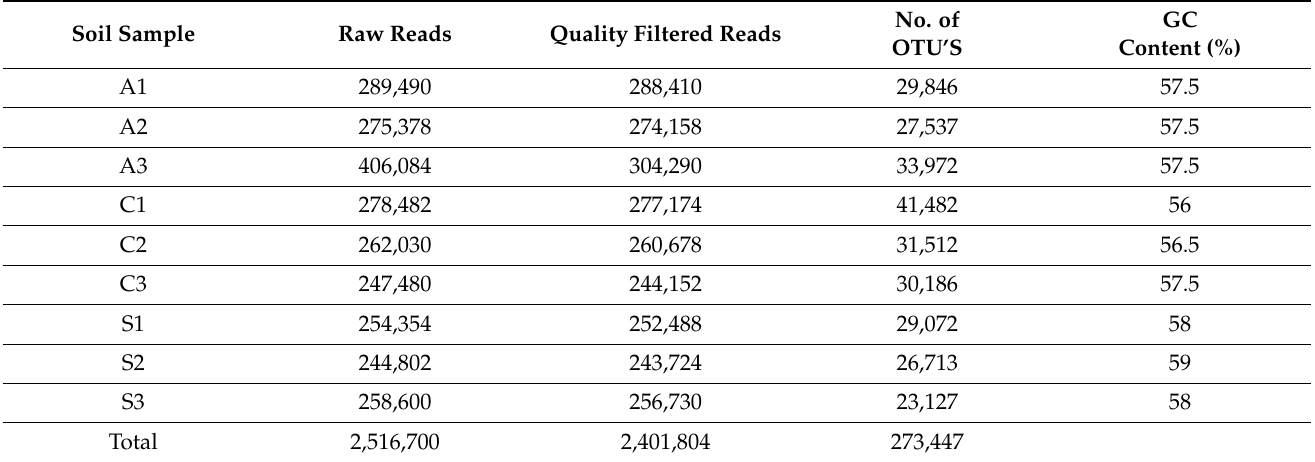
Table 3. Estimators of number of reads, observed OTUs and GC content of soil samples of different planting systems.